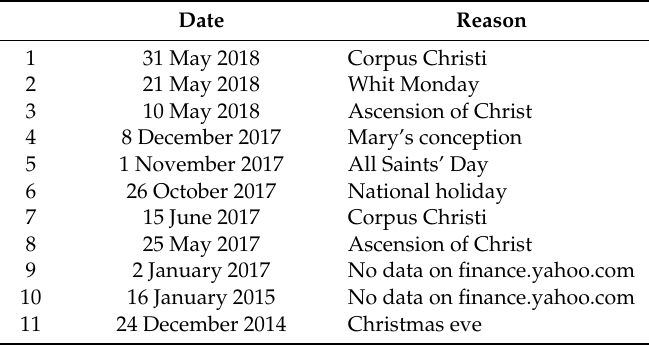
Table A1. Days when the ATX was not published.